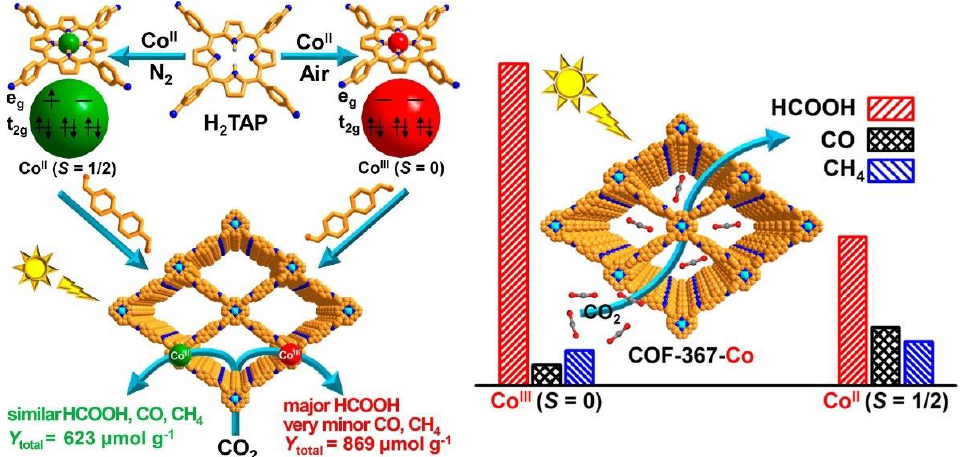
Figure 8. Rational fabrication of COF-367-Co featuring different spin states of Co ions toward photocatalytic CO 2 reduction. Adapted from reference [60] with permission from the American Chemical Society, copyright 2020.